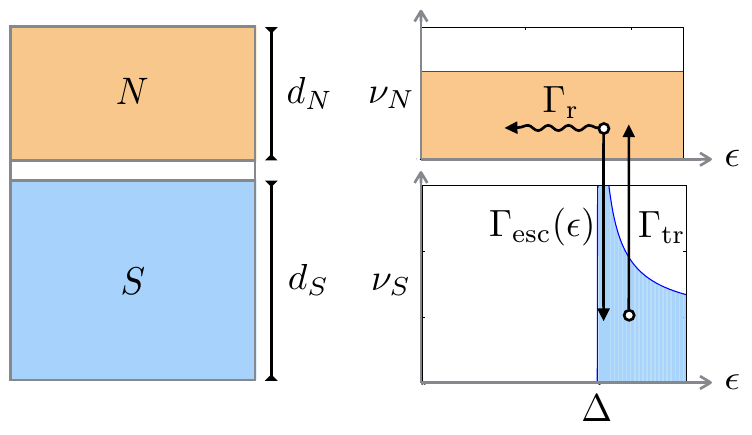
Figure 10: (from Ref. [ 31 ] ) Left: a normal-metal layer N of thickness d is in tunnel N contact with a superconductor S of thickness d . Right: depiction of the processes S determining the effective trapping rate: tunneling into the normal metal with rate Γ , tr relaxation to below the gap ∆ with rate Γ , and escape back into the superconductor r ( ε ) . While the normal-metal density of states is featureless (top), the with rate Γ esc superconductor’s one is peaked at the gap and zero below it